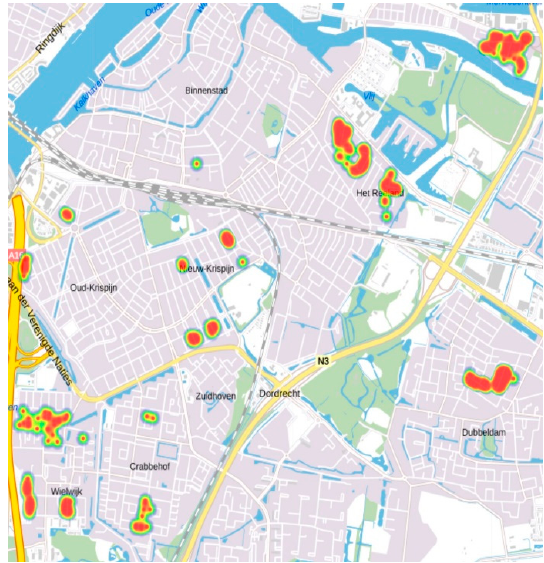
Figure 7. Visualization of the query results on a map showing potential areas for urban development (Source: authors).